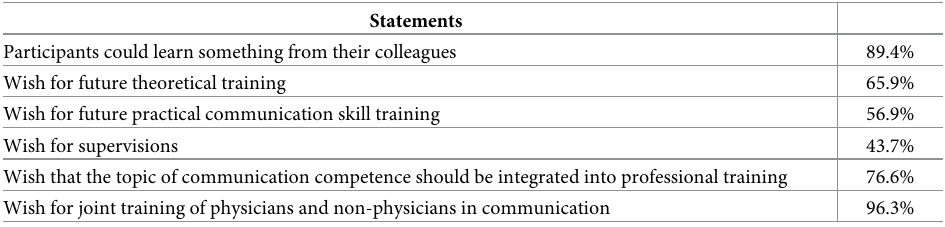
Table 6. Future training in